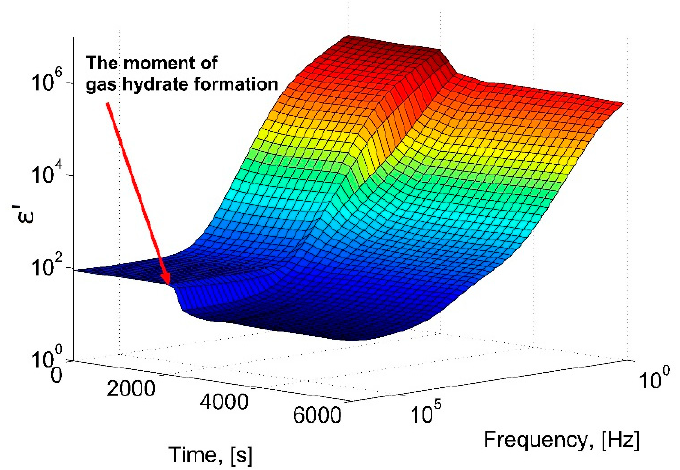
Figure 3. A 3D-diagram of the dependence of the real part of the dielectric constant during the hydrate formation at 273 K, 9